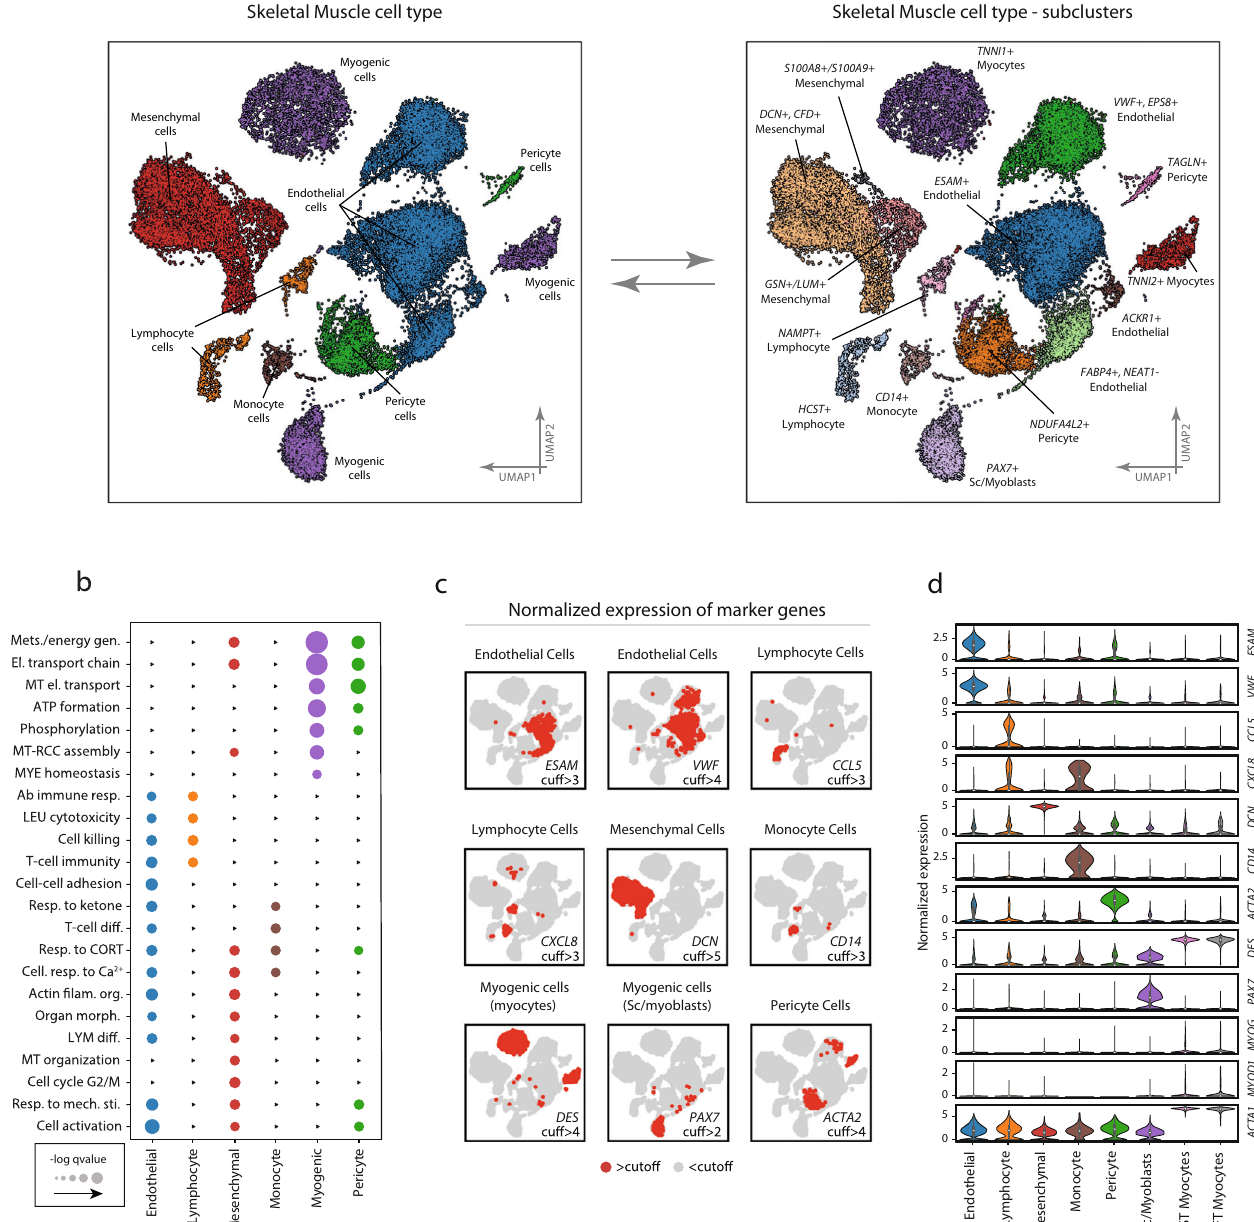
Fig. 2 Cell-type and subpopulations. Marker expression, and ontology enrichment across the different cell types and subpopulations. a Cell-type annotation was based on a combination of marker gene expression compared with the CellMatch database in relation to pro fi les of speci fi c cell types in the Human Gene Atlas. Six different cell types/lineages were identi fi ed and color-coded on the UMAP: Endothelial cells, Myogenic cells, Mesenchymal cells, Myeloid cells, Lymphoid cells, and Pericyte cells. Distinct cell clusters derived from the same cell type were compared and characterized through differential expression. Four subpopulations of endothelial cells were identi fi ed to differ by the expression of VWF + / EPS8 + , ESAM + , and FABP4 + / NEAT − , respectively. There were three mesenchymal subpopulations characterized by differential expression of DCN + / CFD + , GSN + / LUM + , and S100A8 + / S100A9 + , and muscle cells could be further subdivided into three myogenic subpopulations, including PAX7 + satellite/myoblast cells, and fast- ( TNNI2 + ) and slow-twitch ( TNNI1 + ) troponin expressing cells. Pericytes characterized by high/marker gene expression of ACTA2 and PDGFR were divided into two subpopulations ( NDUFA4L2 + and TAGLN + ). One monocyte population was found to express CD14 . b Enrichment analysis of biological functions in the different cell populations shows functionally different gene expression pro fi les for the different cell types. Color coding represents different cell-type and larger dot radius denotes more signi fi cant biological function ( fdr < 0.05). c Marker gene expression in the different cell populations. Red and gray colors indicate the expression of each marker gene above and below hard threshold in all cells, respectively. d Quantitative comparison of the expression of the marker genes in the different cell types. The data in boxplots nested within violin plots are expressed as median, interquartile range, minimum and maximum values. Normalized expression refers to log(1 + x) if not stated otherwise. SC satellite cells; ST slow-twitch, FT fast-twitch, cuff cutoff. Complete marker-gene differential expression can be found in Supplementary Data 2 –